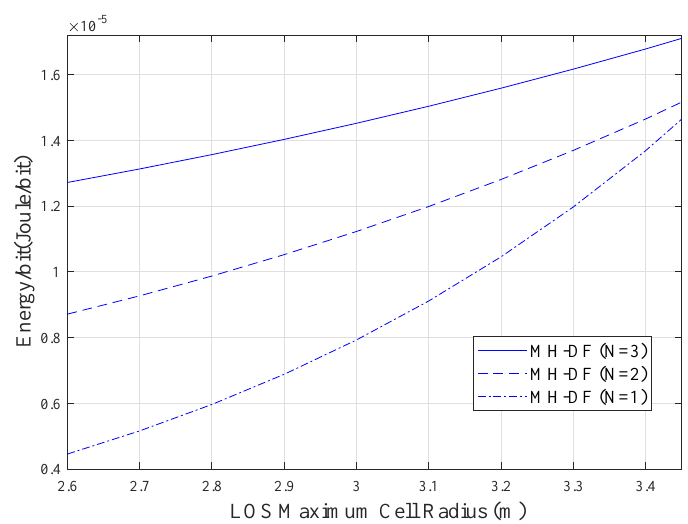
Figure 10. Energy-per-bit performance of the multi-hop system.